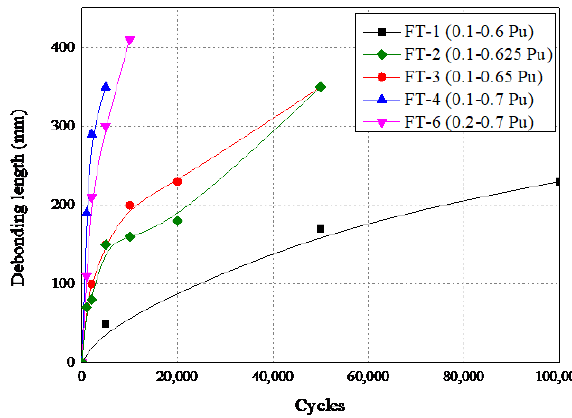
Figure 12. Debond lengths of each specimen at different cycles.